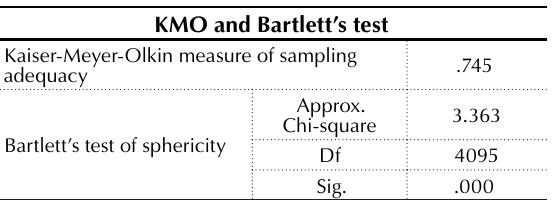
Table 1. Kaiser-Meyer-Olkin measure of sampling